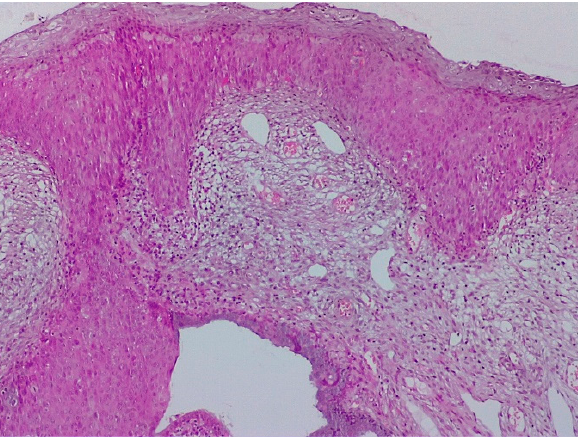
Figure 5. CIN 2—histological specimen after biopsy of the previous case. We notice a condiloma- like aspect of the Malpighian epithelium, the loss of nuclear polarity in two-thirds of the epithelial thickness, and a lot of koilocytes in the intermediary layer and ulcerate junction.